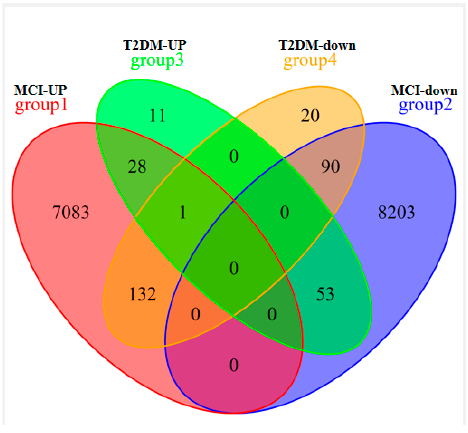
Figure 2. Venn diagram of coDEGs.